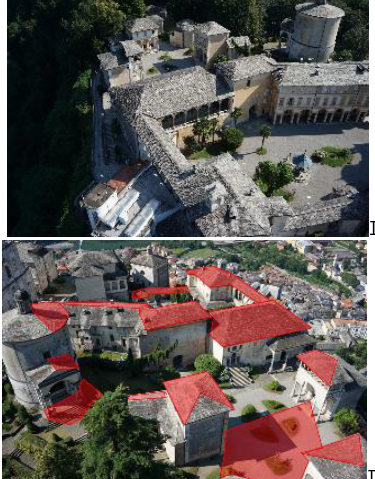
Figure 7. Example of the same area acquired in near strips, with opposite flying directions; the overlapping areas are underlined (in red in